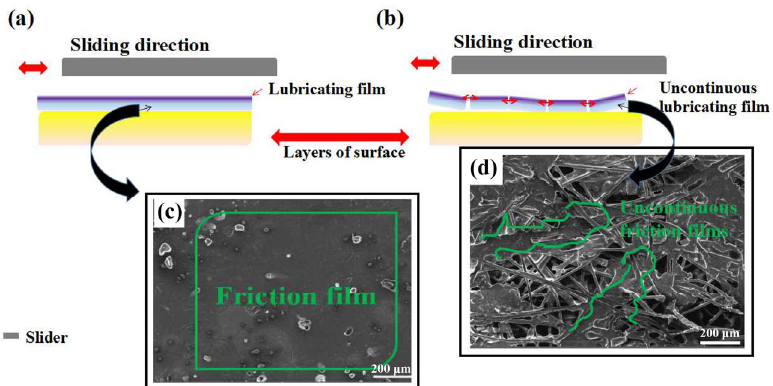
Fig. 11 Schematic diagram of possible behavior of different samples during actual working conditions under lubrication conditions: (a) S1 and (b) S3. Surface micrograph of friction film for (c) S1 and (d)